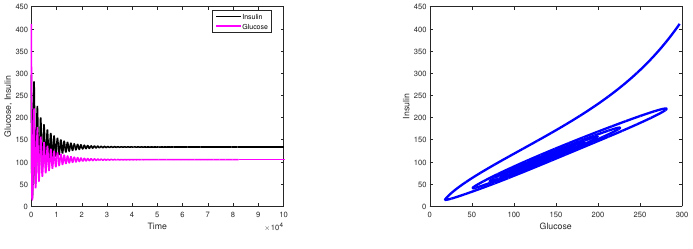
Figure 1. Glucose-insulin dynamics: dynamics and phase plain for τ = 400 < τ ∗ = 457 min.